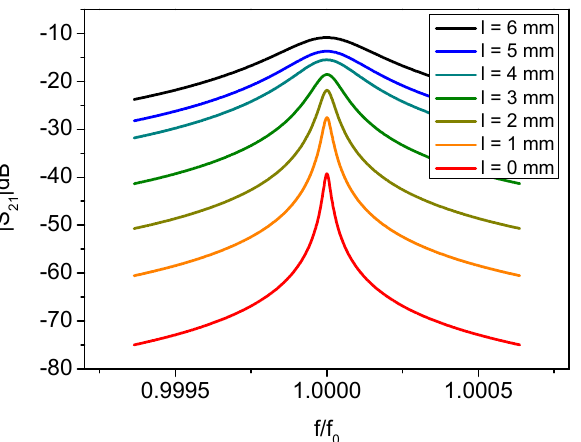
Figure 2. Magnitude of the resonator transmission coefficient (S 21 ) with different antennas length ( l ). Only the fitted Lorentzian function of the measured spectrum is reported here. The shorter are the antennas, the higher is the quality factor and the lower is the peak amplitude.